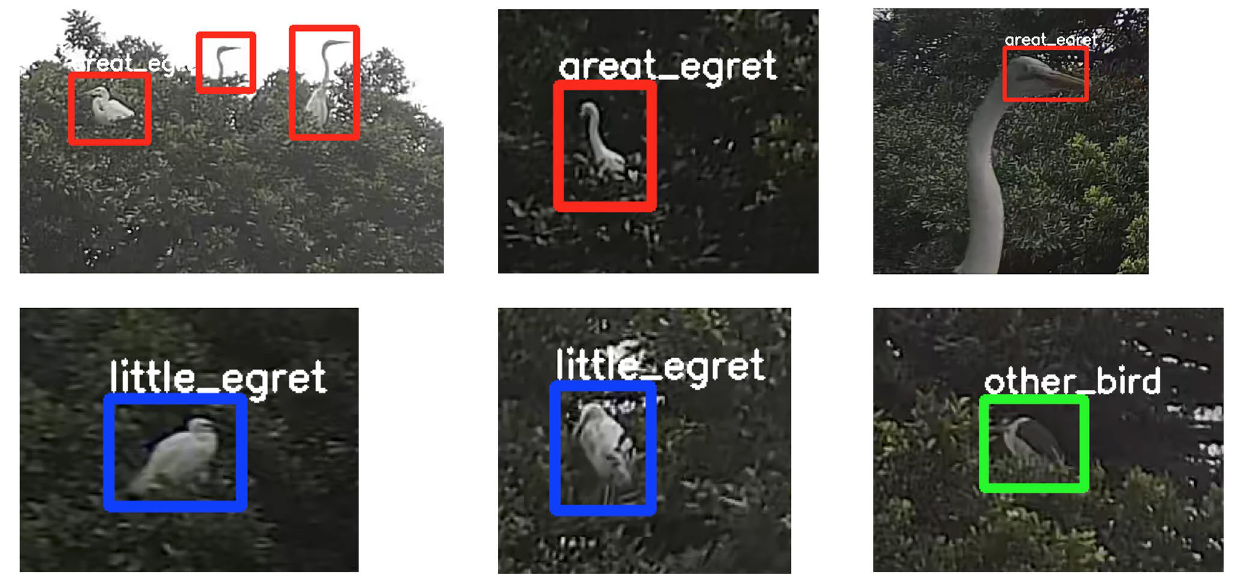
Figure 4. Example of bird detection result. The blue, orange and green bounding boxes are used for the predictions of the great egrets, little egrets and other